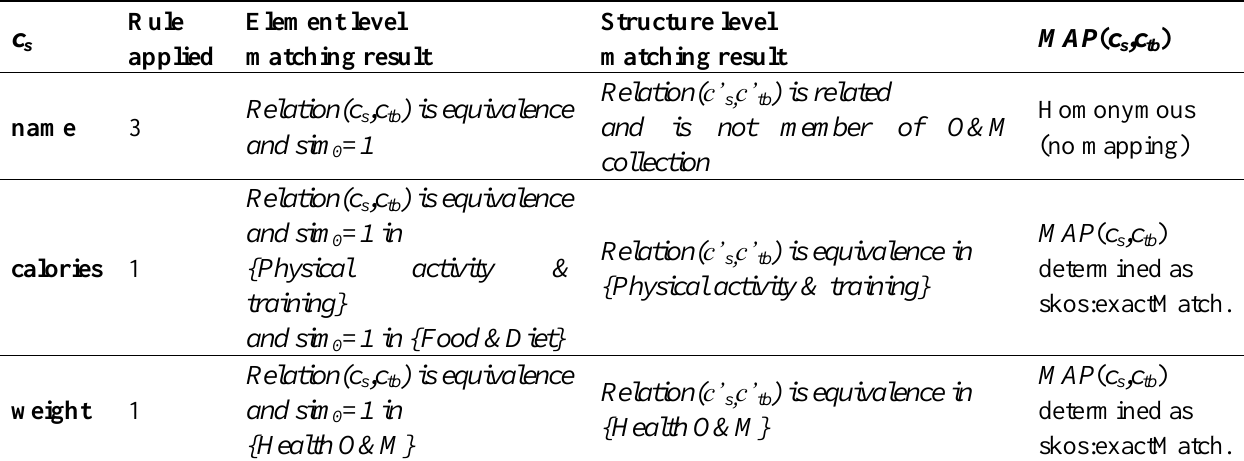
Table 8. Mappings determined after rule